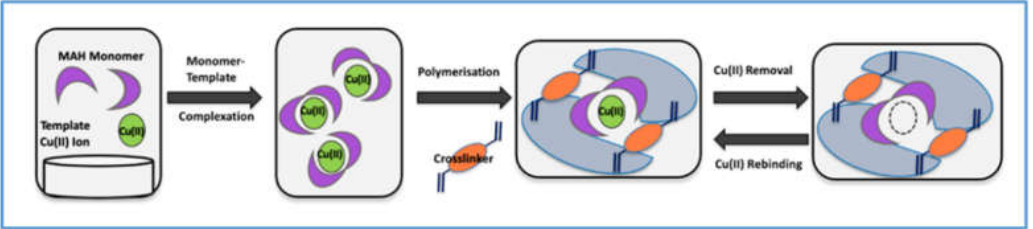
Figure 2. FTIR spectra of MAH monomer (upper), MAH-Cu(II) (middle), and 2MAH-Cu(II) (bottom) complexes. Fingerprint area: red circles.